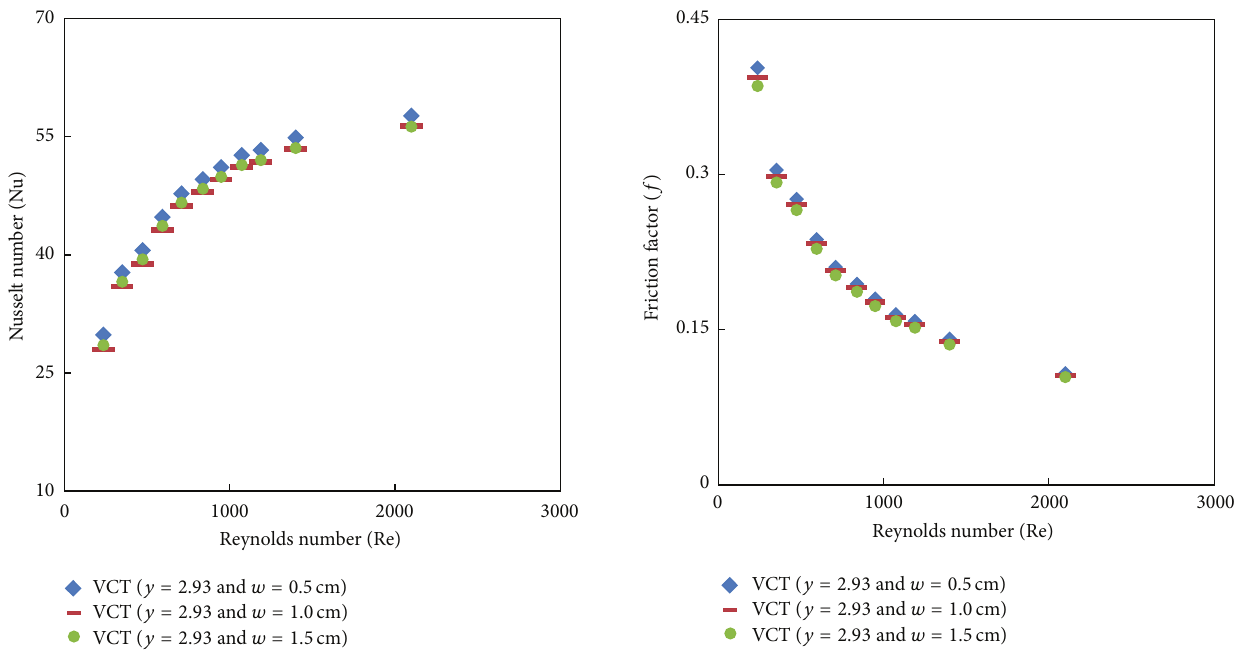
Figure 8: Simulated Nusselt number of V-cut twisted tape with different twist ratios ( 𝑦 ) and different cut depths.